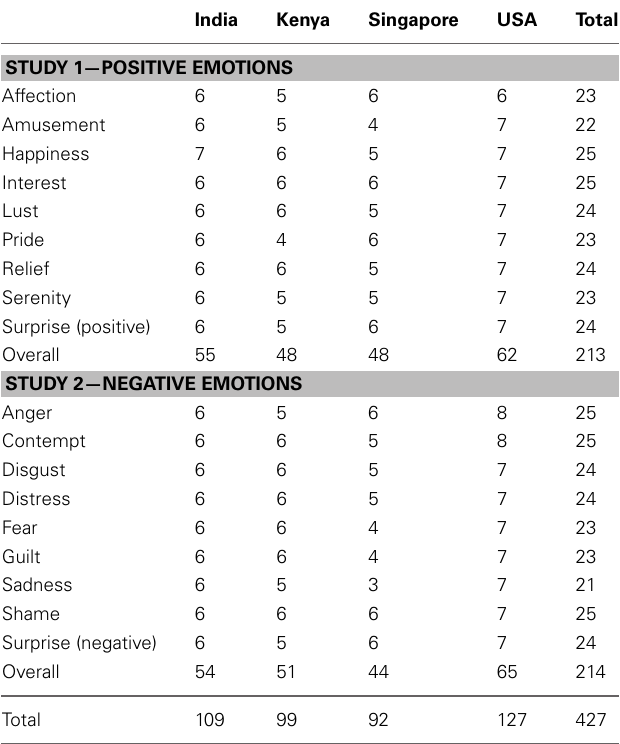
Table 1 | Number of non-linguistic vocalizations for each emotion and